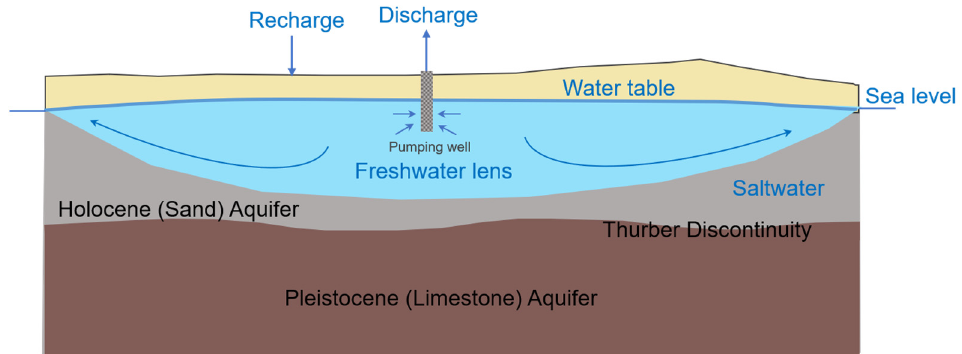
Figure 1. Conceptual sketch of a freshwater lens in a small coral